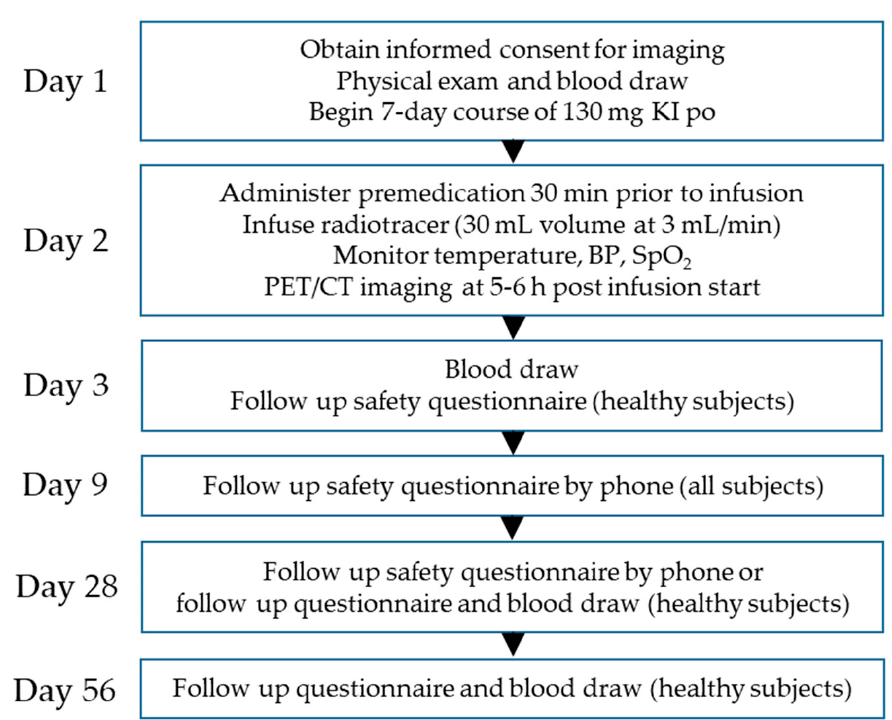
Figure 2. Phase 1/2 study design. Participants were asked to begin a 7-day course of potassium iodide (KI; iOSAT, ANBEX INC., Livingston, NJ) to reduce thyroid exposure to radioactivity. Prior to infusion, participants were given acetaminophen (650 mg) and diphenhydramine (or a suitable alternative; 25 mg). Vital signs were monitored prior to, during, and for 50 min after the infusion of 124 I-p5+14.